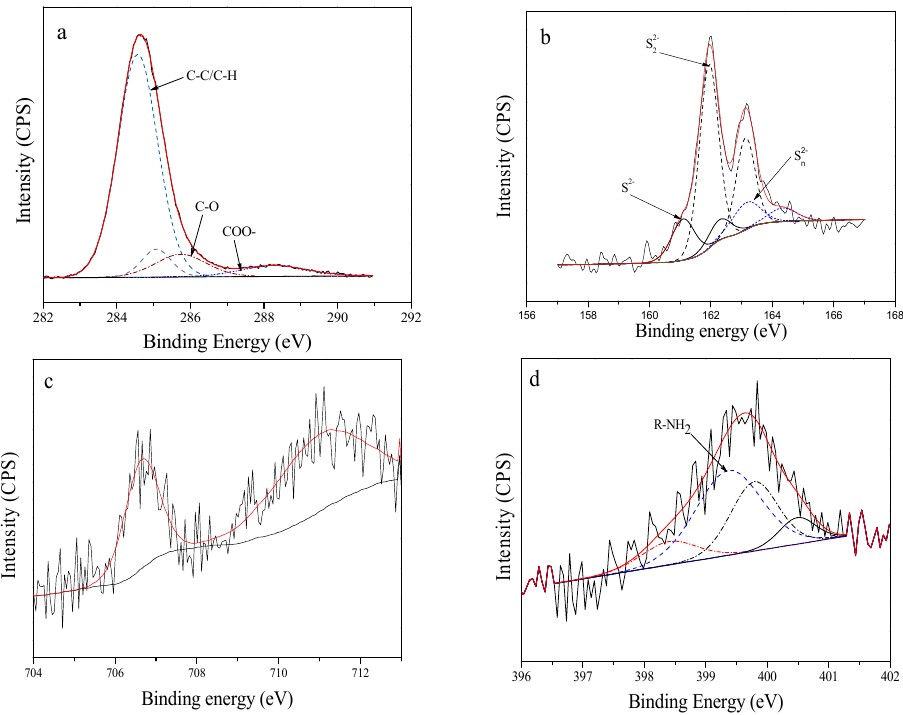
Figure 8. Carbon 1s ( a ), sulfur 2 p ( b ), iron 2 p 3/2 ( c ) and nitrogen 1s ( d ) XPS spectra of cysteine adsorption on pyrite (1 0 0).